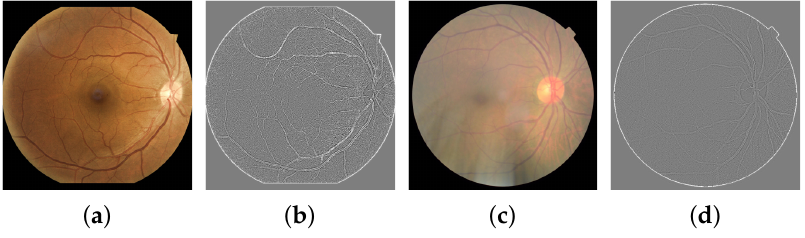
Figure 4. Original images and their Laplacian representations. ( a ) Normal RFI. ( b ) Laplacian, B = 19.75. ( c ) Blurred RFI. ( d ) Laplacian, B =